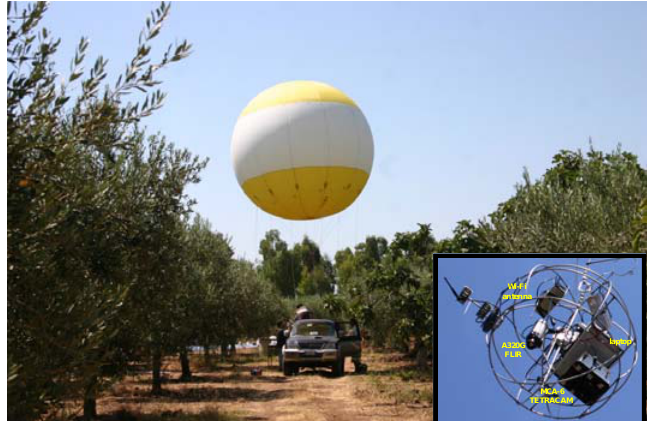
Figure 2. The tethered helium balloon during the launching phase. In the inset (lower right corner), there is an image of the proximity-sensing platform, which includes an MCA-II multispectral camera, an A320G thermal camera, a mini PC, and a wireless Wi-Fi omnidirectional antenna. Images were acquired on 1 August 2009 at spatial resolutions of 0.12 m (multispectral) and 0.50 m the “suitable” structural resolutions for evapotranspiration retrievals at plant and plot scales.